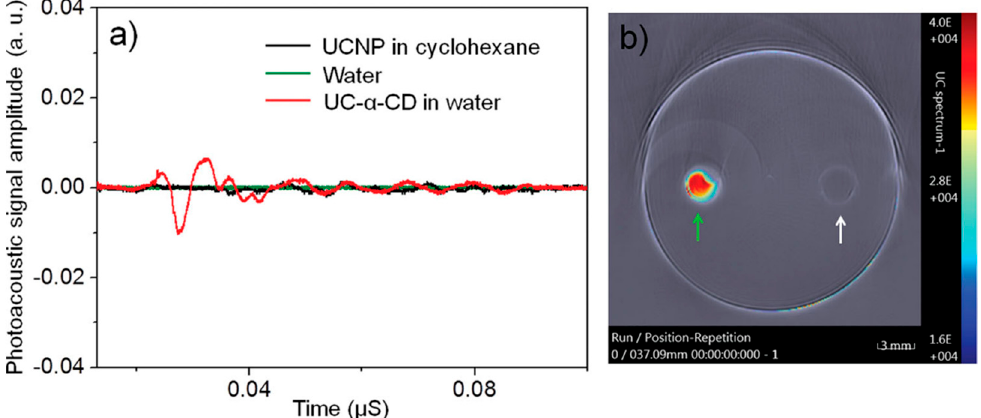
Figure 9. ( a ) High-resolution PA signal originated from upconversional NPs (UCNPs) in cyclohexane (black curve), distilled water (green curve), and α -CD/UCNPs (red curve) in water. The excitation was conducted using 980 nm nanosecond pulsed laser. ( b ) Photo-acoustic imaging (PAI) of tissue-mimicking phantom containing chambers filled with α -CD/UCN in water (green arrow) and distilled water (white arrow) [49]. The images are reprinted with permission from the publisher [49].